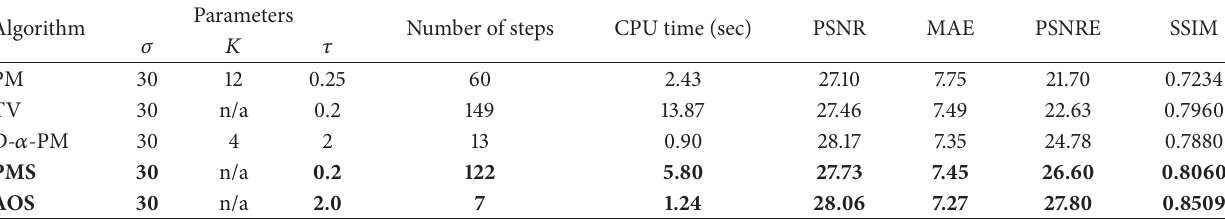
Table 2: Numerical results for Lena image (300 × 300)